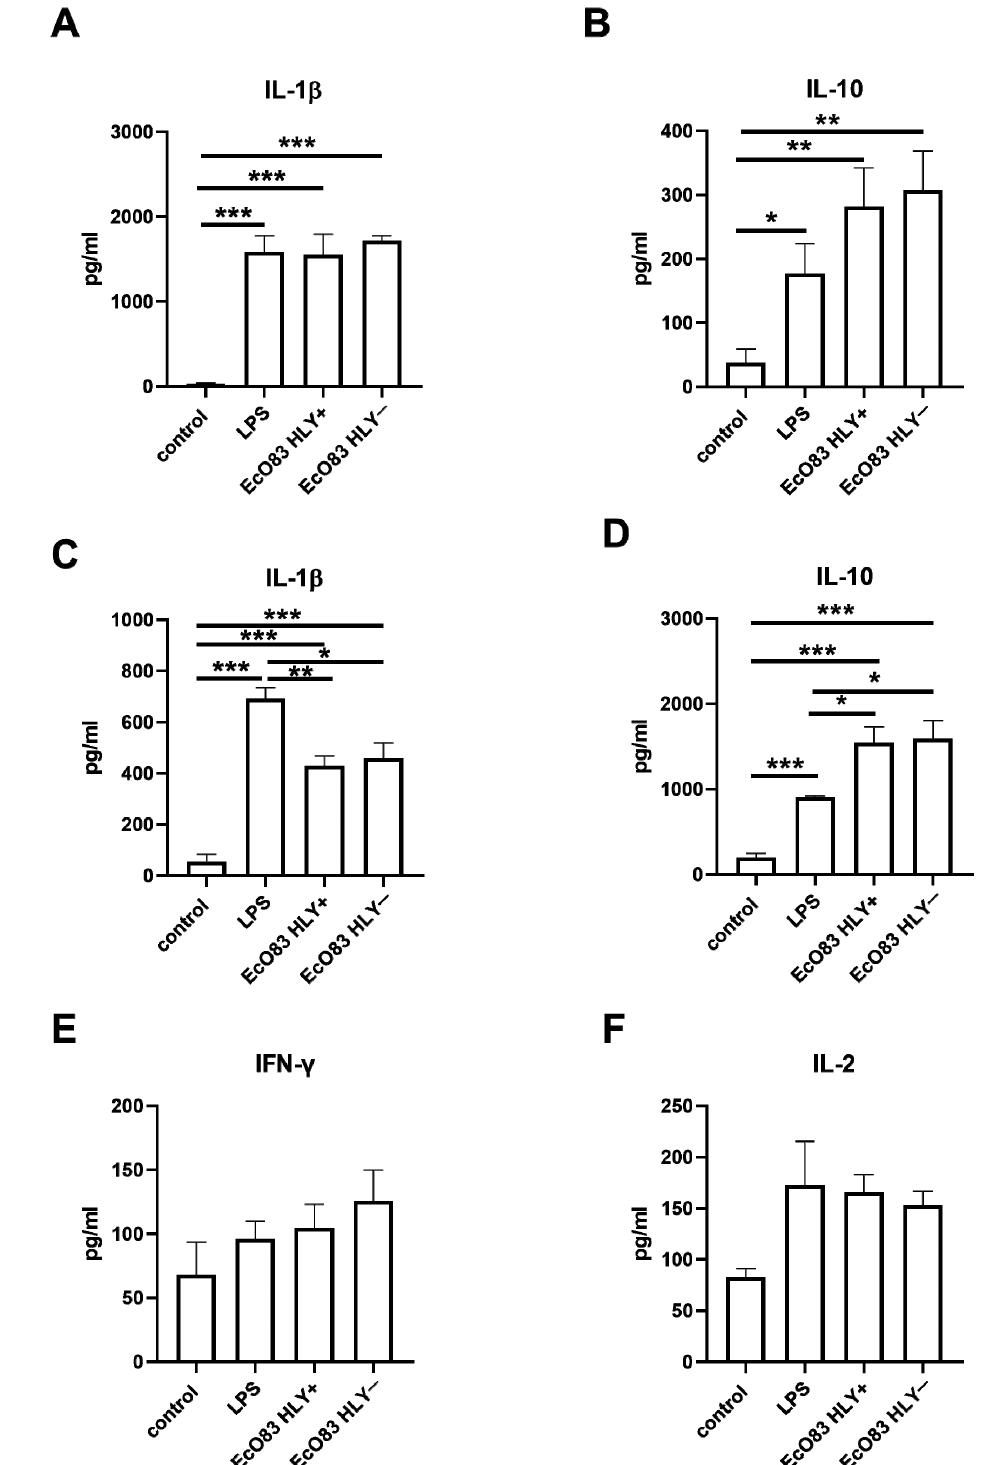
Figure 3. Detection of cytokines in cell culture supernatants. Bone marrow-derived dendritic cells (BMDC) were stimulated by lipopolysaccharide (LPS) and hemolysin positive (HLY+) or hemolysin negative (HLY − ) strains of E. coli O83:K24:H31 (EcO83) for 24 h and cell culture supernatants were inspected for IL-1 β ( A ) and IL-10 ( B ) by ELISA. The capacity of HLY+ and HLY − EcO83- and LPS- stimulated BMDC to modulate cytokine production in naïve CD4 + T cells upon coculture. Detection of IL-1 β —( C ), IL-10—( D ), IFN- γ —( E ) and IL-2—( F ) by ELISA. * p ≤ 0.05, ** p ≤ 0.01, *** p ≤